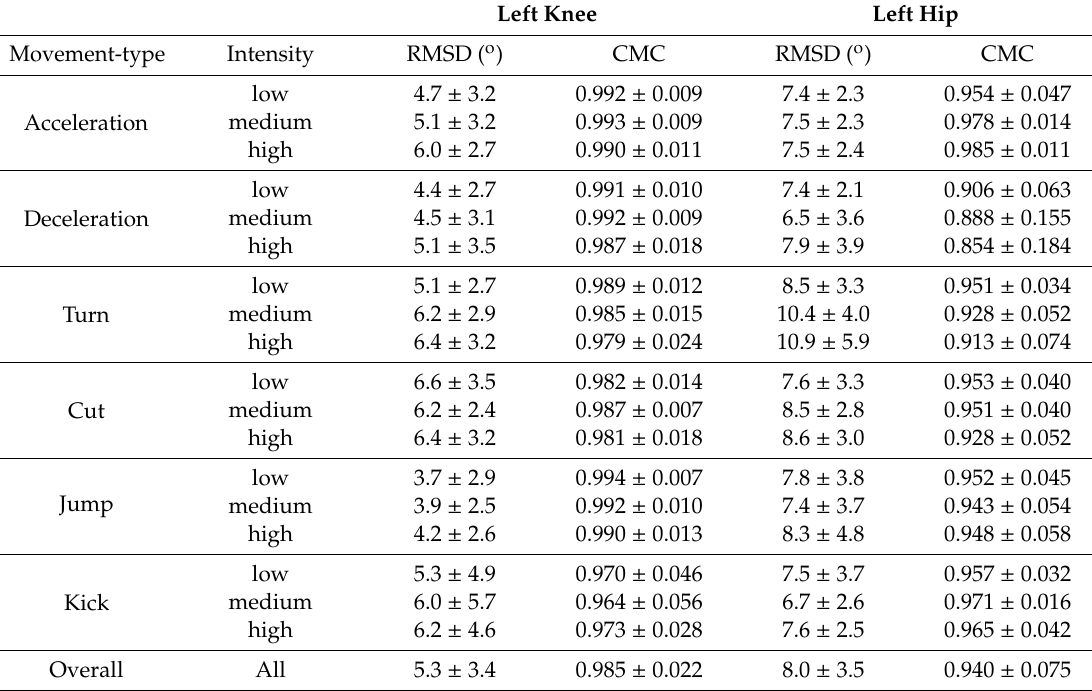
Table 1. Results joint flexion / extension angles. Root mean square di ff erences (RMSD) and coe ffi cients of multiple correlation (CMC) between knee and hip flexion / extension angles of the left leg obtained by the optoelectronic and inertial-based motion analysis